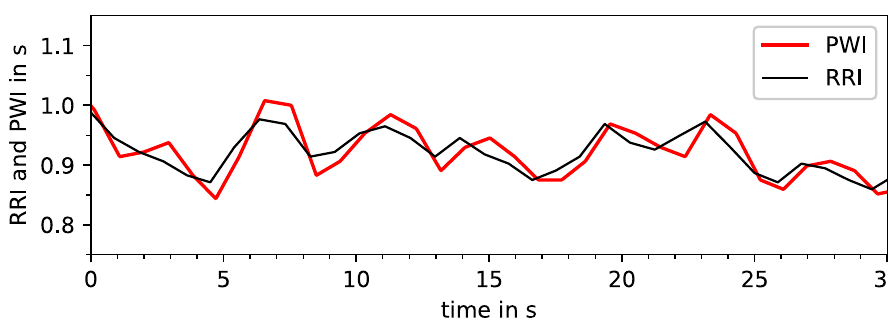
Fig 10. Tachogram of respiratory sinus arrhythmia. This plot shows how RRI (black) and PWI (red) follow oscillations due to respiratory sinus arrhythmia.